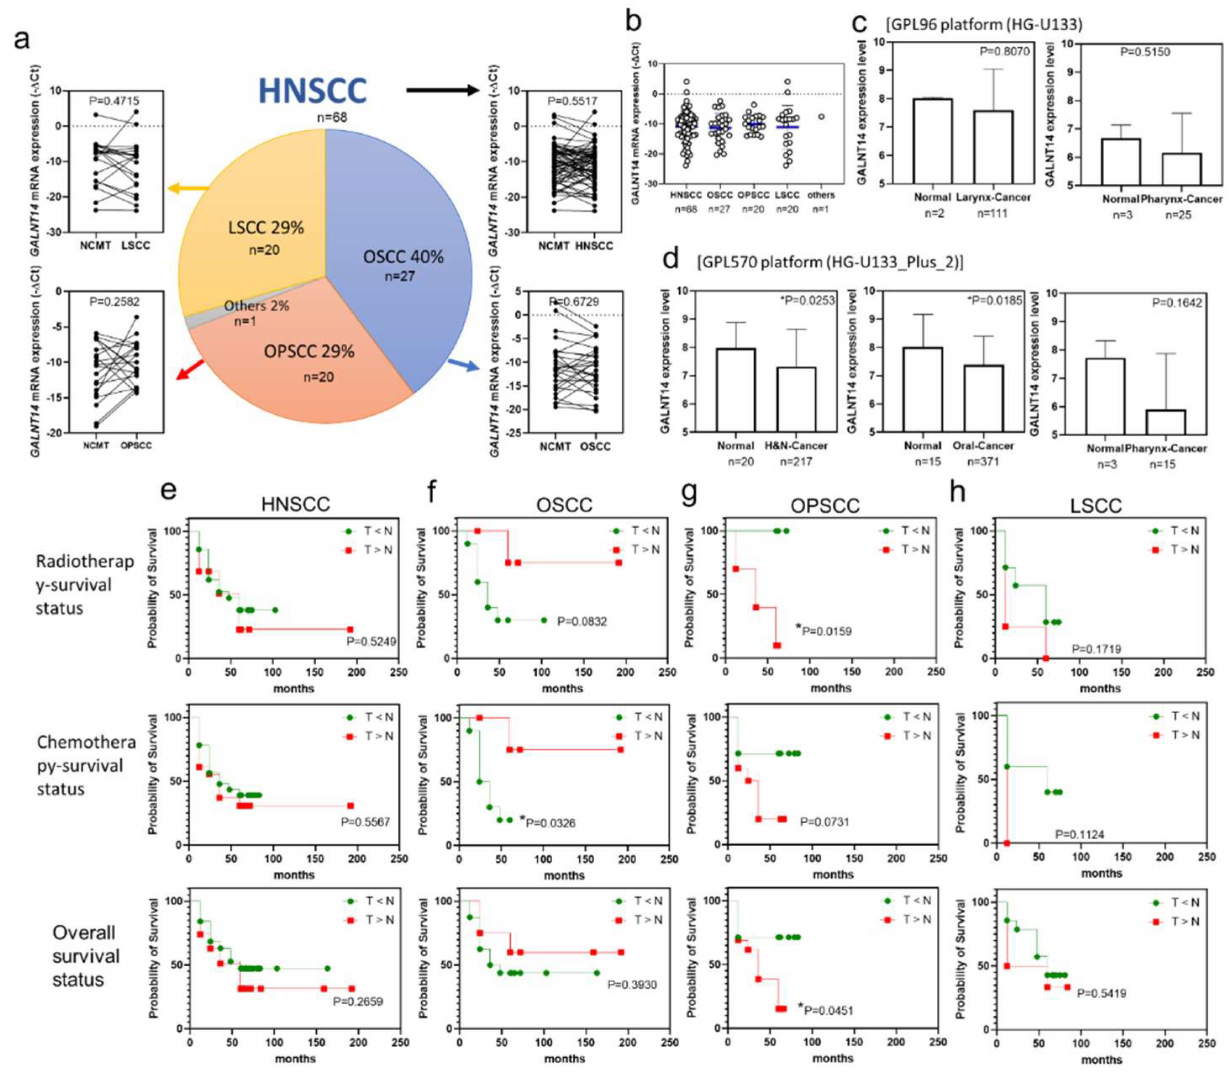
Figure 2. Relation between GALNT14 mRNA expression ( − ∆ Ct) trend and radiotherapy, chemother- apy, and overall survival in HNSCC and its subtypes. ( a ) 68 NCMT and HNSCC (include 27 OSCC, 20 OPSCC, 20 LSCC, and 1 other cancer subject) paired tissues were analyzed by RT-qPCR. Paired t -test was used to analyze the data. ( b ) GALNT14 expression level ( − ∆ Ct) in HNSCC, OSCC, OPSCC, LSCC, and other cancers. One-way ANOVA was used to analyze the data. ( c ) GALNT14 expression level in larynx normal and cancer tissues. ( d ) GALNT14 expression level in head and neck normal and cancer tissues, oral normal and cancer tissues, and pharynx normal and cancer tissues. n, sample size. For ( c , d ), Mann–Whitney test was used to analyze the data. * p < 0.05. The data generated in this analysis are publicly available in GENT2 at GPL95 platform (HG-133) and GPL570 platform (HG-133-Plus-2). Survival curves of patients with lower (T < N) and higher (T > N) GALNT14 mRNA expression in tumor (T) compared to NCMT (N). ( e ) HNSCC, ( f ) OSCC, ( g ) OPSCC, and ( h ) LSCC. Log-rank test; * p <